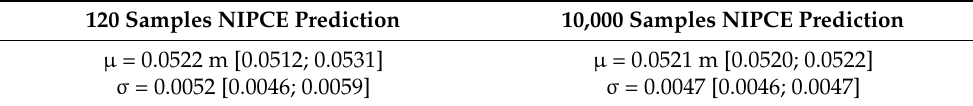
Table 4. PDF of normal distribution parameters of Figure 9’s histograms. 120 Samples NIPCE Prediction